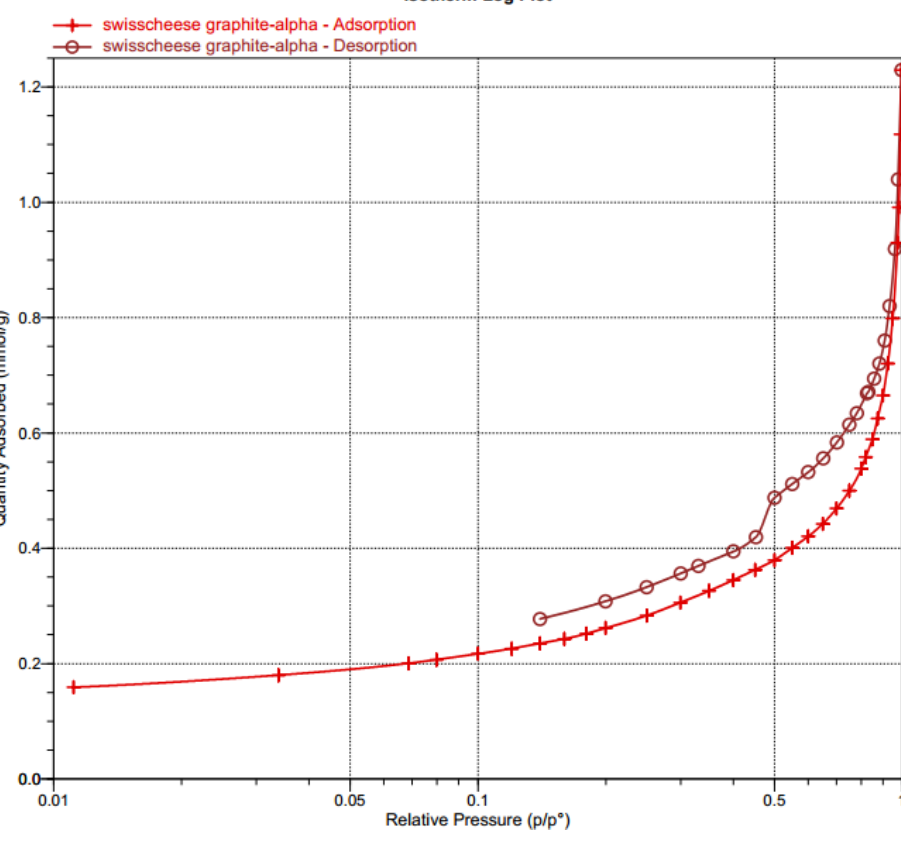
Figure A1. TEM micrographs of ( A ) Swiss-Cheese-Graphite after 30 min of ball mill and ( B ) heat- treated anthracene coke after 30 min of ball milling.